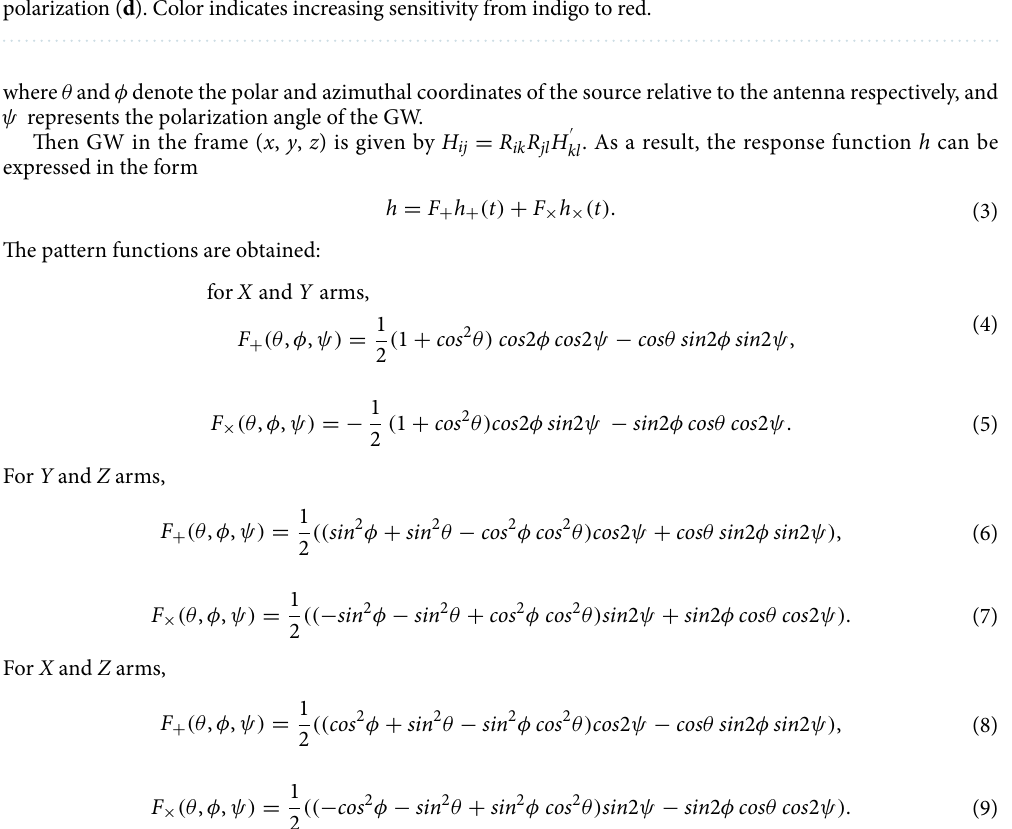
where θ and φ denote the polar and azimuthal coordinates of the source relative to the antenna respectively, and ψ represents the polarization angle of the GW. Then GW in the frame ( x , y , z ) is given by H ij = R ik R jl H